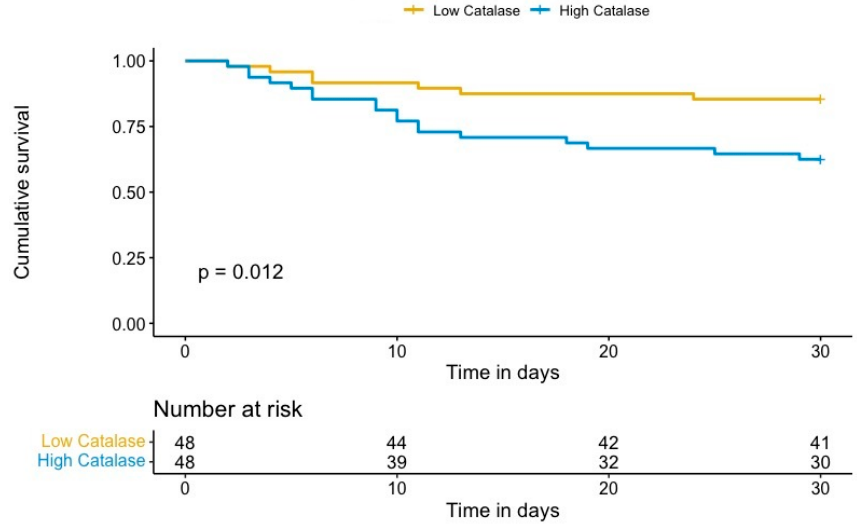
Figure 1. Kaplan–Meier estimates of 30-day mortality for OHCA survivors with high (log 2 intensity ≥ 8.25) and low catalase levels (log 2 intensity < 8.25). Table 3. Univariate and multivariable models for risk factors associated with mortality after out-of-hospital cardiac arrest.